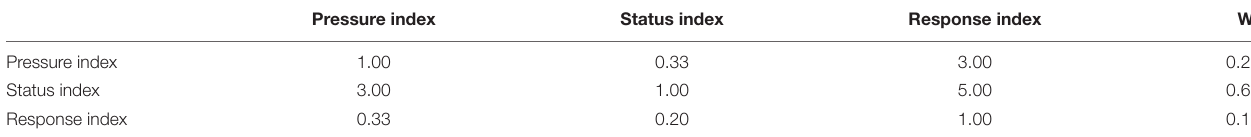
Frontiers in Ecology and Evolution |